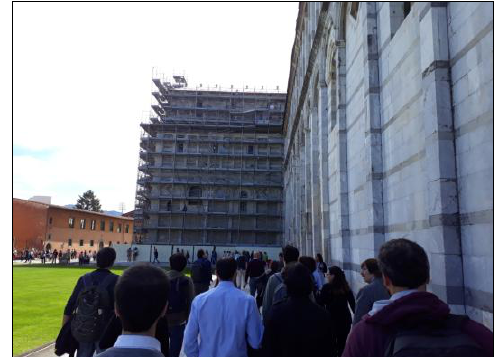
Figure 1. External view of the Transept of the Cathedral